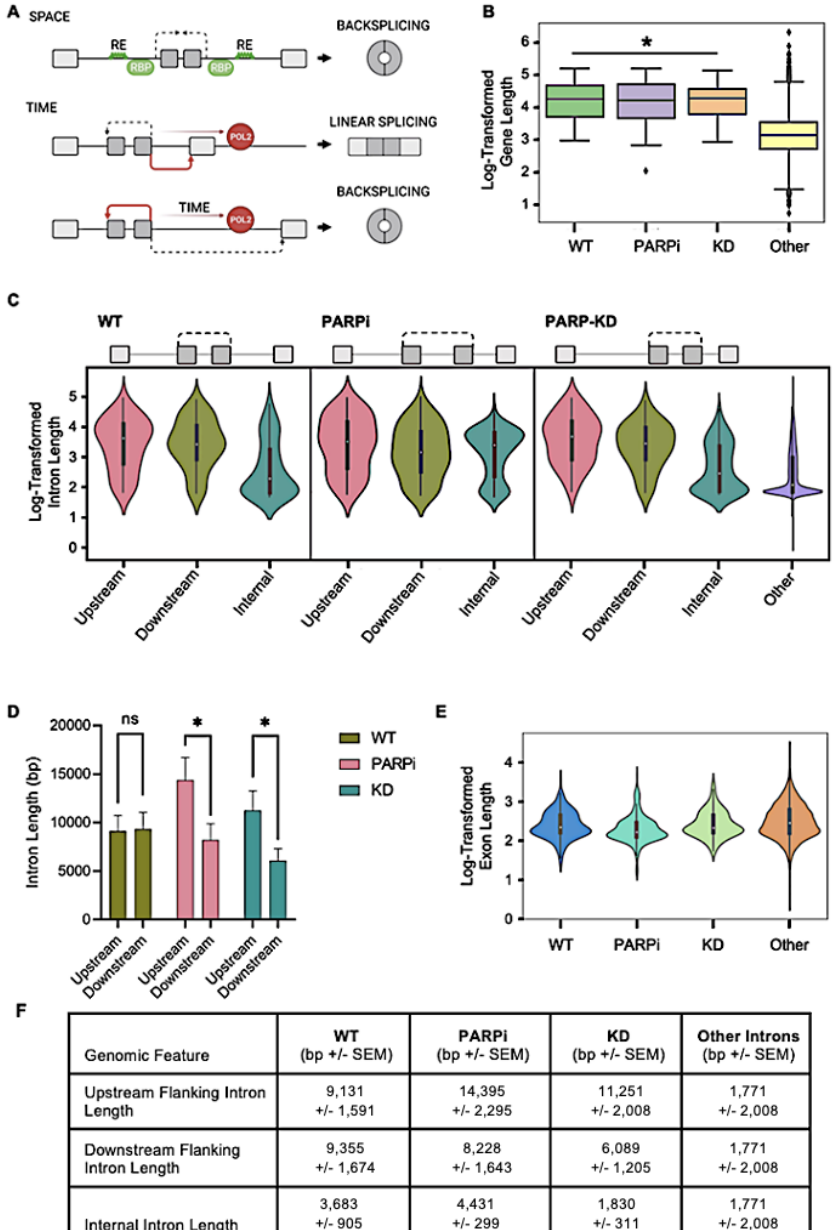
Figure 5. Linear architecture of circRNA host genes is altered upon PARP1 disruption. ( A ) Schematic diagram describing the influence of transcriptional space and time on backsplicing. Boxes represent exons, lines represent introns, factors regulating transcriptional space are green, RNAPII is red. Repeat elements and RBPs in flanking introns bring backsplice sites into close physical proximity to promote backsplicing. The prolonged time it takes for RNAPII to travel to a downstream acceptor provides a window of opportunity for backsplicing to occur. ( B ) Mean length of WT (green), PARPi (purple), PARP KD (orange) host gene lengths compared to other Drosophila genes (yellow) (* p < 0.01 vs. Other). ( C ) Lengths of upstream introns (pink), downstream introns (green), and internal introns (teal) compared to other Drosophila introns (purple) in WT (left), PARPi (middle), and PARP KD (right). ( D ) Bar graph highlighting the difference in upstream vs. downstream intron lengths (bp) in WT (green), PARPi (pink), and PARP KD (teal). Students t -test comparing upstream to downstream (* p < 0.05, error bars represent SEM). ( E ) Lengths of exons in WT (blue), PARPi (teal), and PARP KD (green) compared to other Drosophila exons (orange). ( F ) Table summarizing the mean lengths shown in the figures.